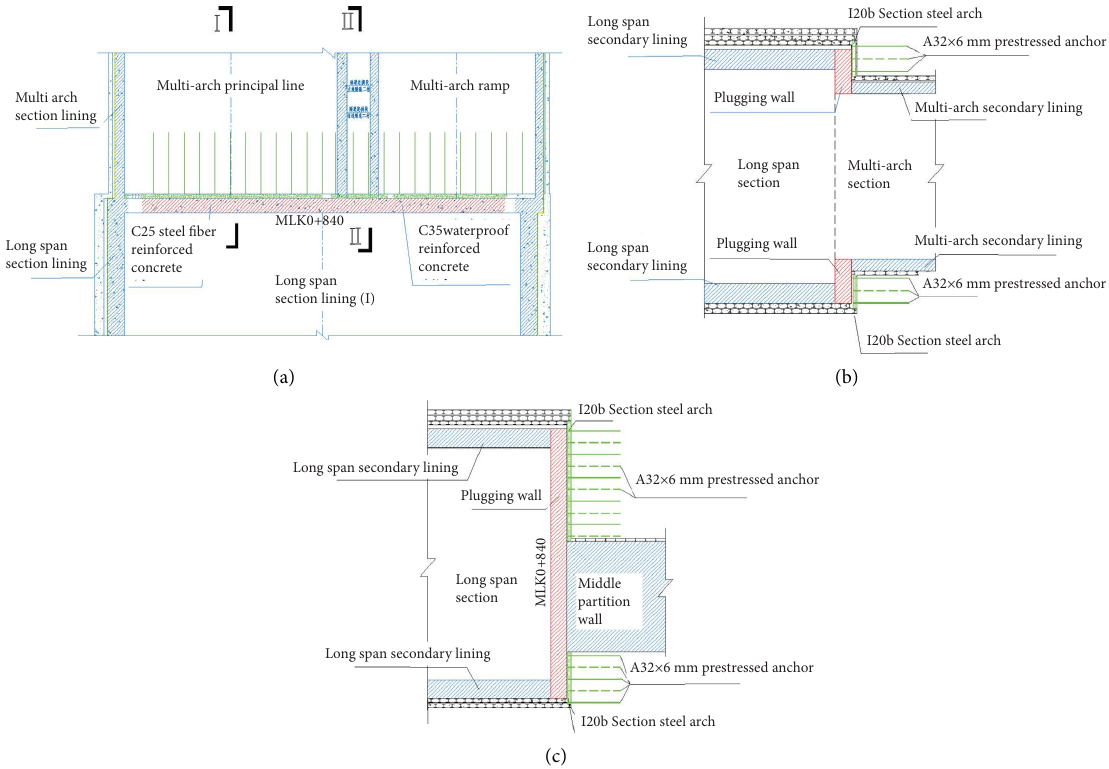
Figure 13: Plan view of plugging wall at transit between multiarch section and large-span section: (a) plan view; (b) section view I-I; (c) section view II-II.